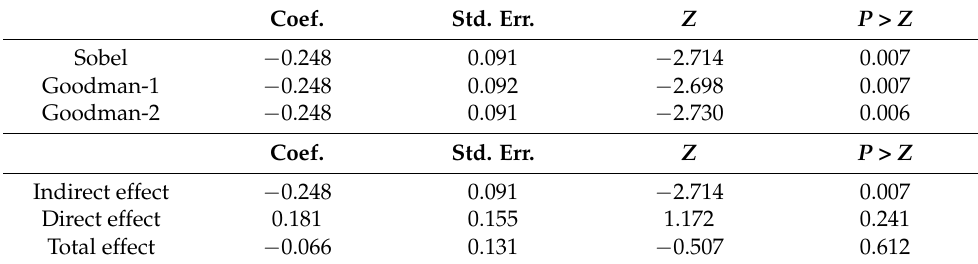
Table 5. Full sample mediation effect estimation results.